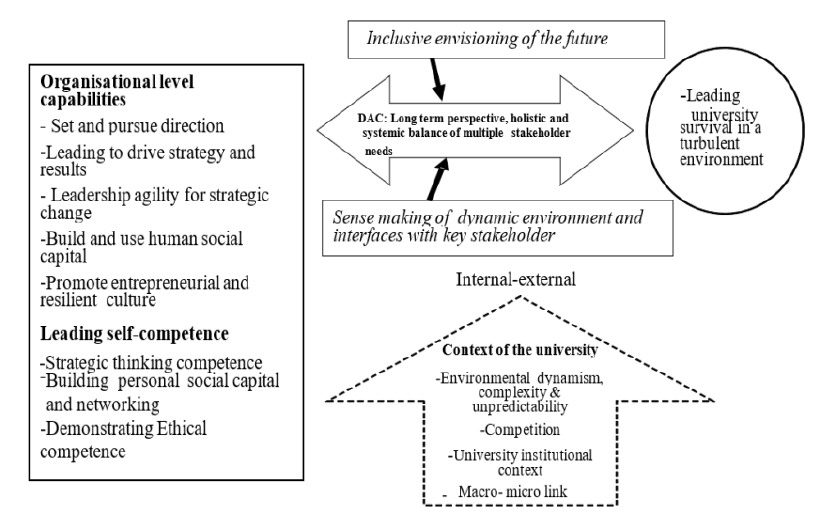
Figure 2: A proposed integrative framework of university strategic leadership; Source: